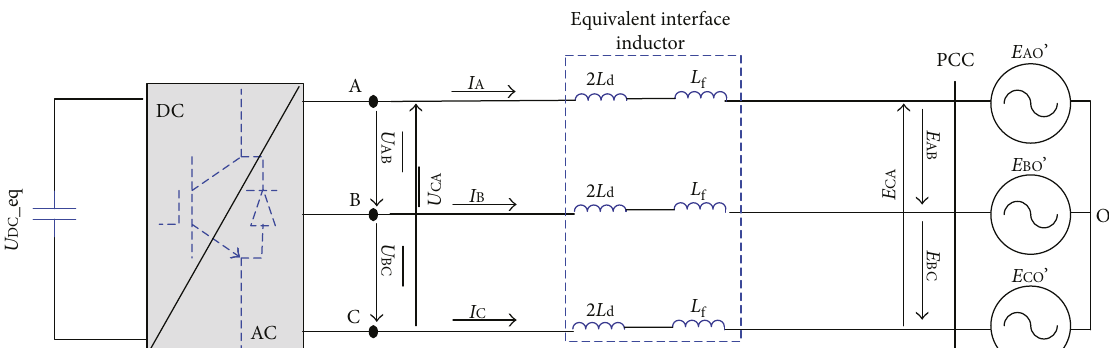
Figure 8: Equivalent circuit model of HMC.